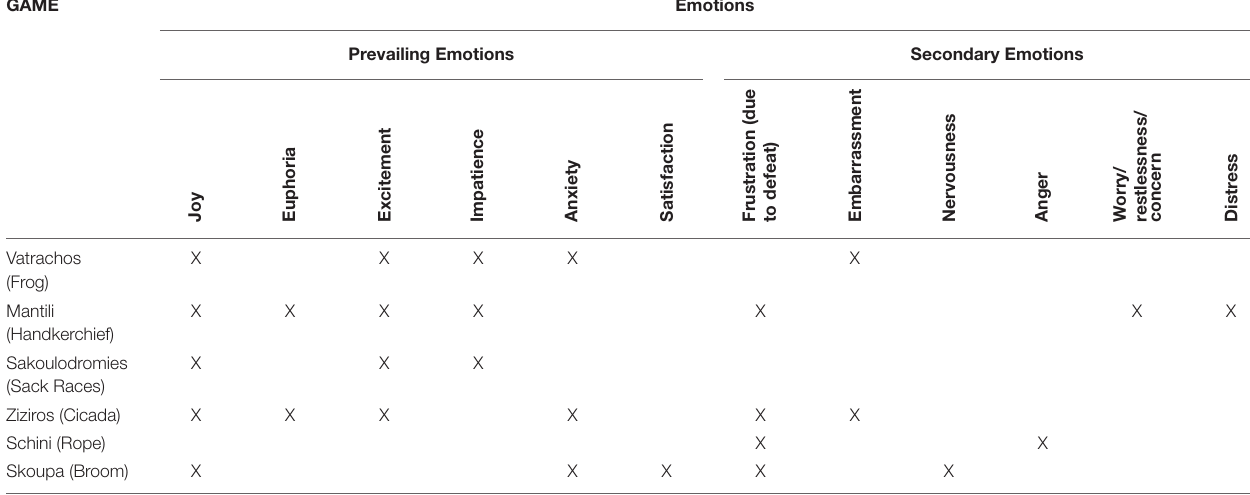
TABLE 2 | Emotions observed in each game.